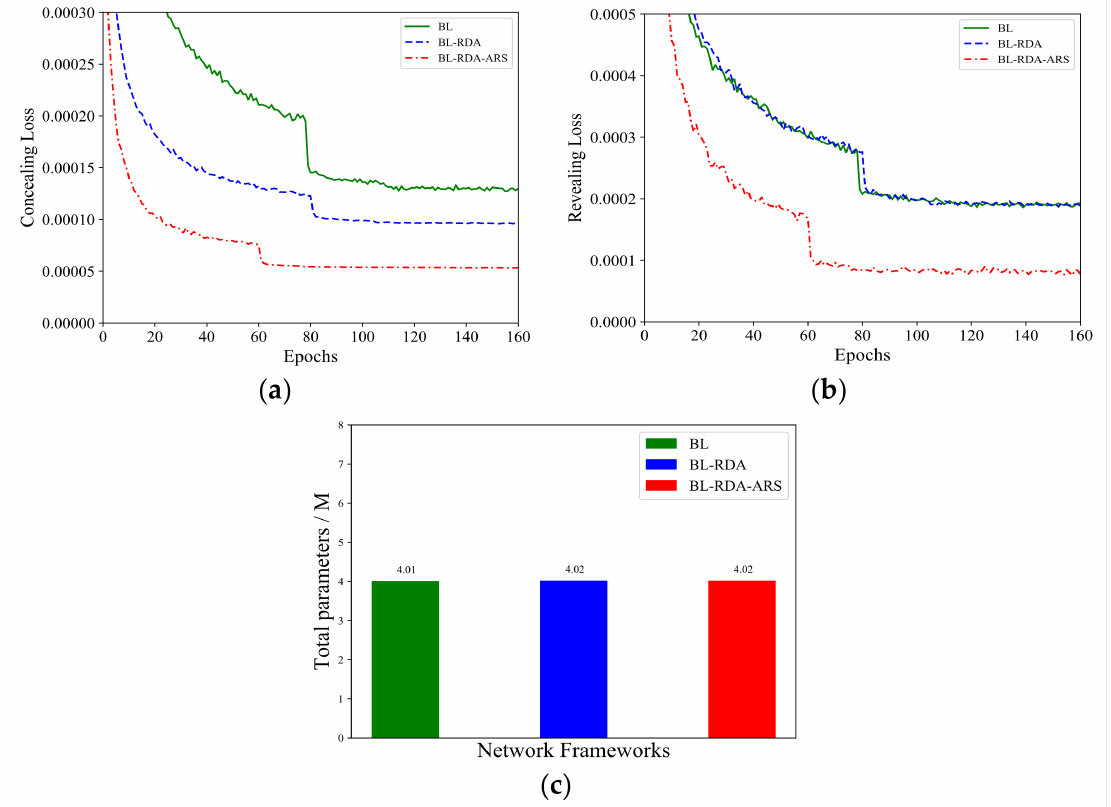
Figure 3. Network performance of different frameworks. ( a ) Concealing loss, ( b ) revealing loss, ( c ) total parameters of different